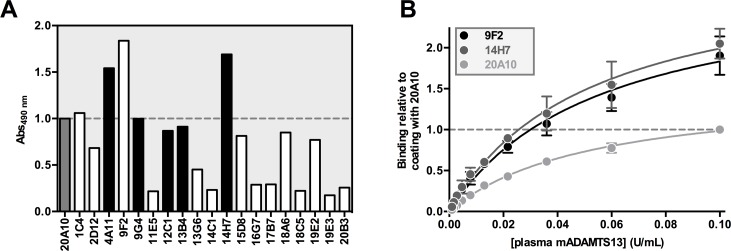
Development of a sensitive mADAMTS13 detection assay.(A) Binding of plasma mADAMTS13 to the anti-mADAMTS13 mAbs was tested in ELISA. The respective anti-mMDTCS (black) and anti-mT2-CUB2 (white) mAbs were coated on a 96-well microtiter plate. After blocking, plasma mADAMTS13 was added (0.1 U/mL) and was detected using the polyclonal anti-mADAMTS13 rabbit IgG and GAR-HRP. (B) The same ELISA was performed as in A in triplicate for anti-mT2-CUB2 mAb 9F2, anti-mMDTCS mAb 14H7 and the previously reported anti-mMDTCS mAb 20A10 [31]. Binding was calculated relative to binding of 0.10 U/mL plasma mADAMTS13 to 20A10 (which was set to a value of ‘1.0’). Error bars represent the SD of the three independently performed experiments.